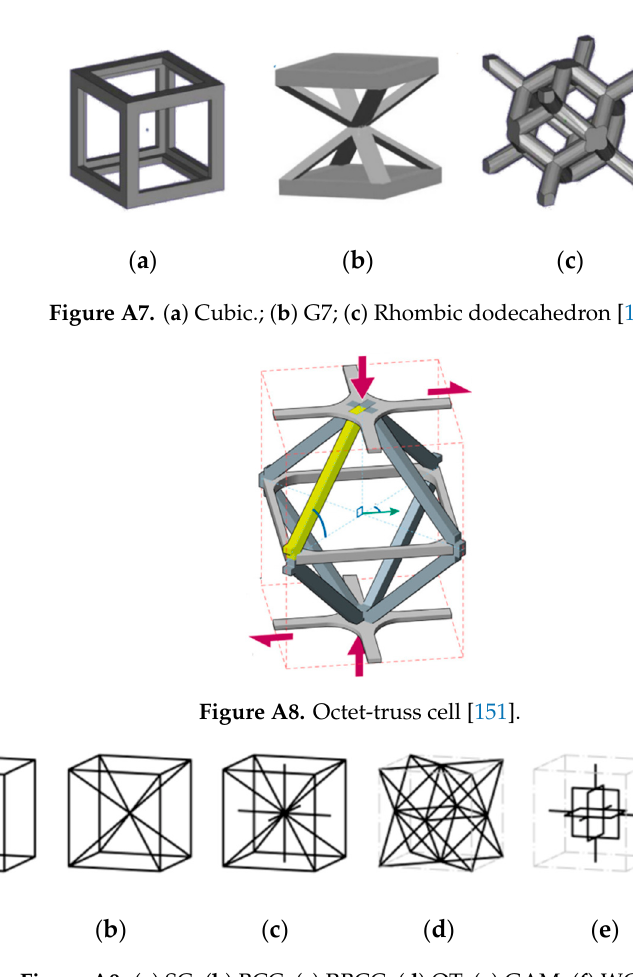
Figure A9. ( a ) SC; ( b ) BCC; ( c ) RBCC; ( d ) OT; ( e ) GAM; ( f ) WG [152].